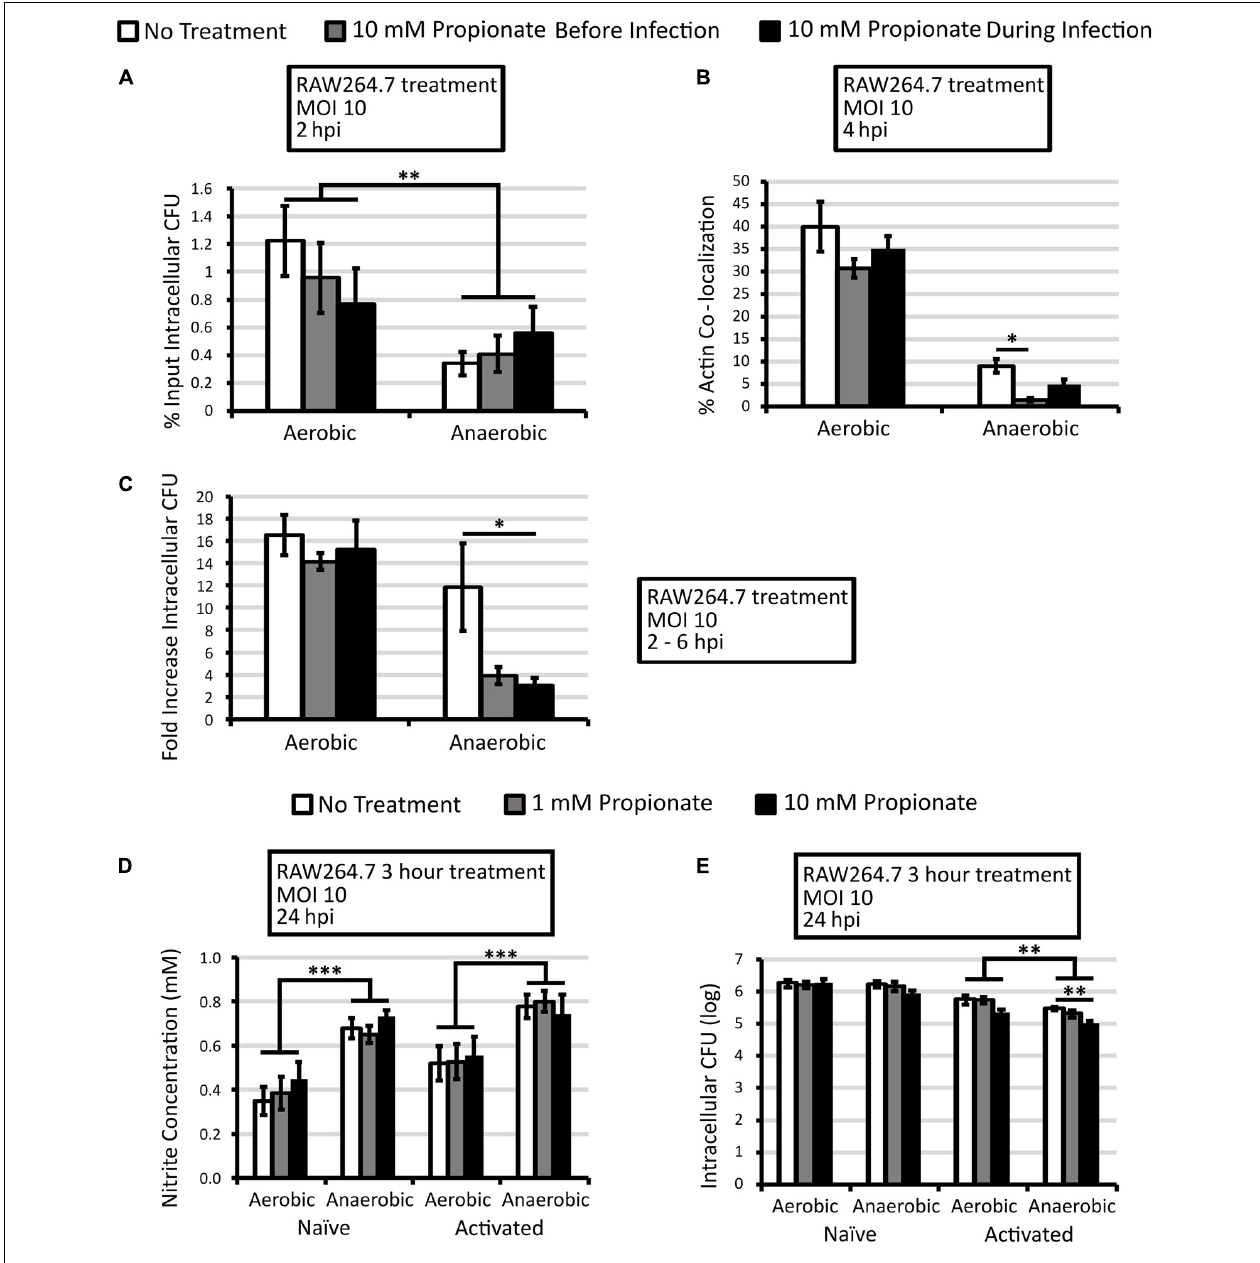
FIGURE 4 | Short propionate pretreatment did not alter NO production by infected macrophages but reduces anaerobic L. monocytogenes infection. (A–C) RAW264.7 macrophages were incubated with or without 10 mM of propionate for 3 h prior to infection (gray bars) or during infection (black bars) by aerobically or anaerobically grown L. monocytogenes. Infected macrophages were lysed at 2 and 6 hpi to enumerate intracellular CFU. Percent input intracellular CFU (A) was calculated by comparing intracellular CFU at 2 hpi to CFU in the infection inoculum. Immunofluorescence microscopy was performed at 4 hpi (B) where filamentous actin and L. monocytogenes were differentially stained and quantified for co-localization. A minimum of 200 L. monocytogenes cells were counted from each replicate and condition over 2 independent experiments performed in duplicate. Averages were plotted with error bars representing standard errors of the mean (B) . Fold increase intracellular CFU (C) was calculated by comparing intracellular CFU between 2 and 6 hpi. Averages from 4 independent experiments, each performed with triplicate, were plotted with error bars representing standard errors of the mean (A,C) . Nitrite concentrations in culture supernatant were quantified for RAW264.7 macrophages treated with or without activation by LPS and IFN γ overnight and with propionate for 3 h prior to infections. Overnight aerobically or anaerobically grown L. monocytogenes were used to infect macrophages for 30 min where supernatant nitrite levels (D) and intracellular CFUs (E) were measured at 24 hpi. Averages are from at least 3 independent experiments, each performed in triplicate, with error bars representing standard errors of the mean (D,E) . Asterisks denote statistical significance between pair-wise comparisons with ∗ p < 0.05, ∗∗ p < 0.01, and ∗∗∗ p < 0.001.